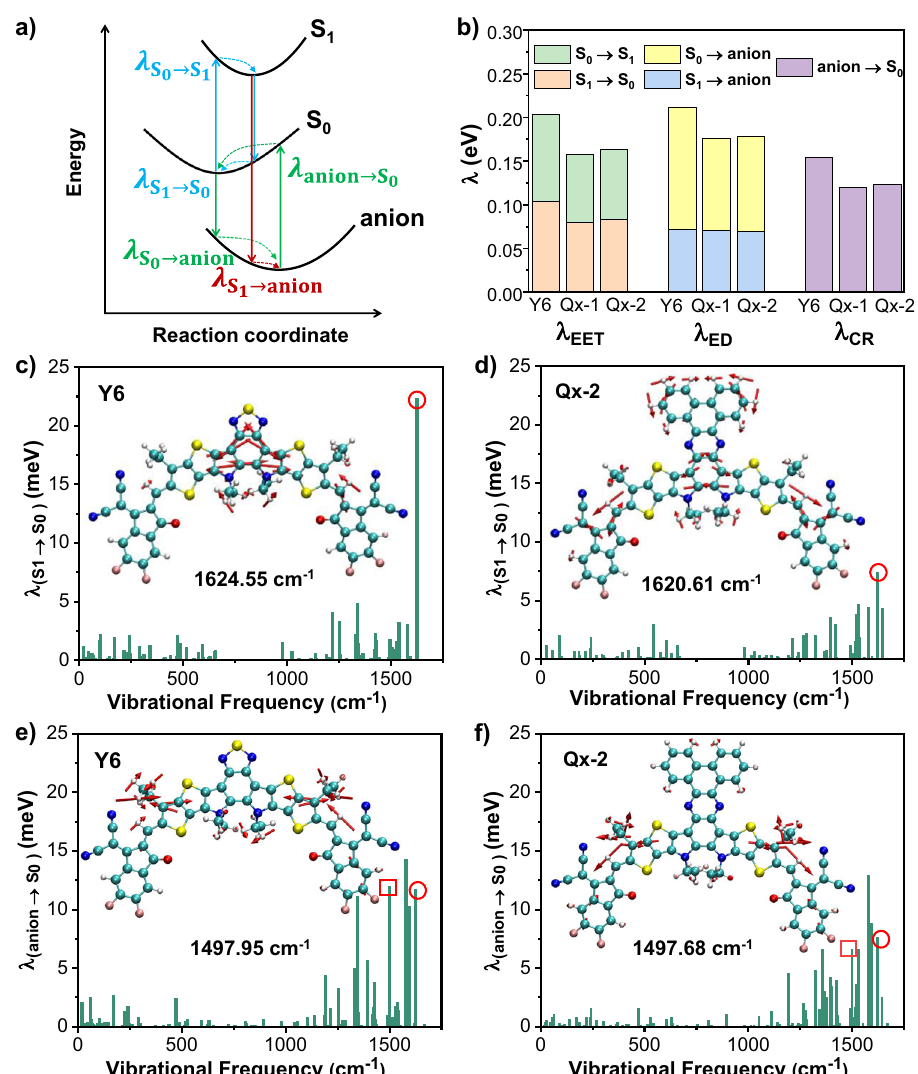
Fig. 2 Reorganization energy of Y6, Qx-1, and Qx-2 acceptors. a Illustration of the related transitions among the ground state (S 0 ), the lowest singlet excited state (S 1 ), and the anionic state during the photoelectric conversion processes, taking the acceptor as an example. b The calculated reorganization energies for the mutual transitions between the different electronic states at the level of ω B97XD/6-31G(d,p) with tuned ω values in Y6, Qx-1, and Qx-2 acceptors. c – f Contributions of each vibrational mode to the reorganization energy for the S 1 → S 0 and anion → S 0 transitions of Y6 and Qx-2. Illustration of the displacement vectors for the vibrational normal modes marked by circles (at around 1625 cm − 1 ) and squares (at around 1498 cm − 1 ) are inserted. The length of displacement vectors stands for the magnitude of vibrational